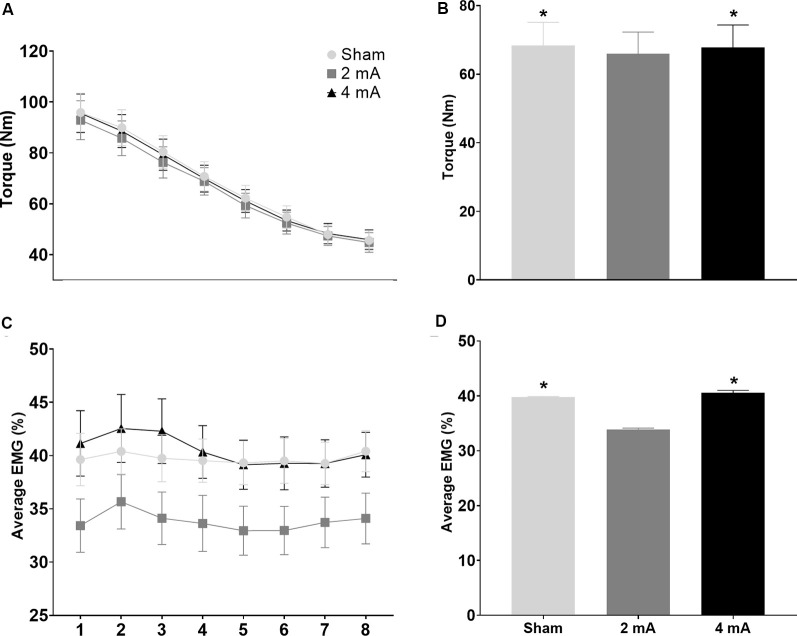
Significant main effects in torque production and EMG activity of the right knee extensors during the isokinetic fatigue test. Data are mean ± SEM. Panels (A,C) respectively show changes in torque production and muscle activity (average EMG %) over the eight time-windows of the isokinetic fatigue test, stratified by tDCS condition (sham, 2 mA, 4 mA). For (A), torque decreased over time and each time window was significantly different from the others (e.g., 1 vs. 2, 1 vs. 3 … 7 vs. 8; significance not indicated on the figure). Panels (B,D) respectively show comparisons of the average torque production and muscle activity (average EMG %) stratified by tDCS condition (sham, 2 mA, 4 mA). In Panels (B,D), *indicates significantly different from the 2 mA tDCS condition. EMG, electromyography; tDCS, transcranial direct current stimulation.